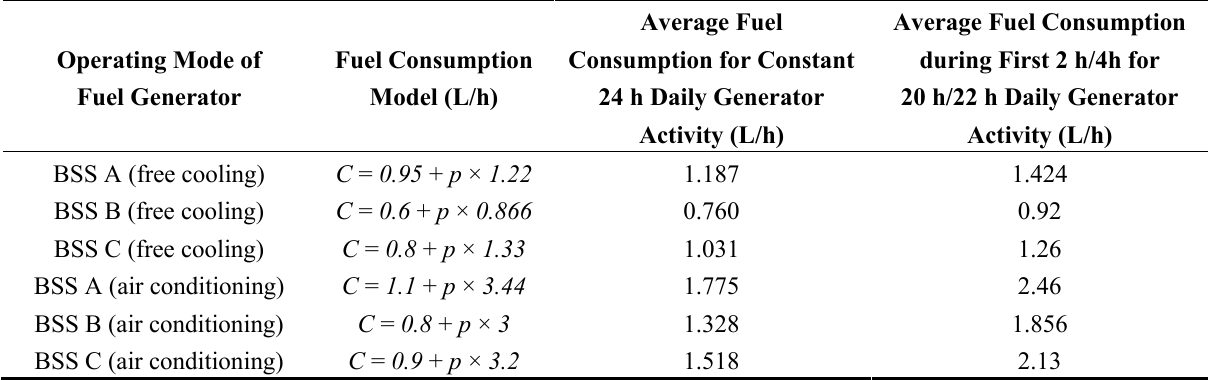
Table 5. Interdependence of fuel consumption and generator load with corresponding consumptions for different operating